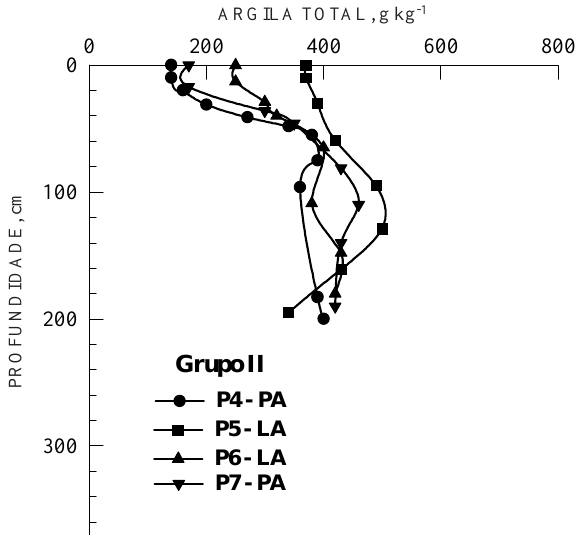
Figura 4. Curvas de distribuição da argila total em profundidade nos perfis desenvolvidos de sedimentos da Formação